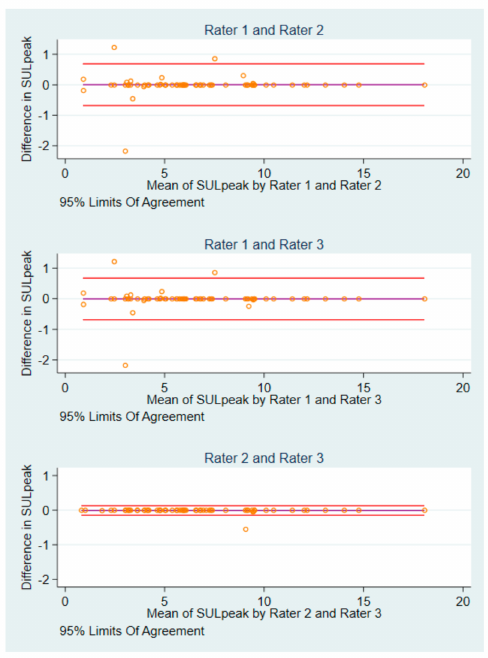
Figure 2. BA plots of SUL peak baseline measurements by pairs of raters.